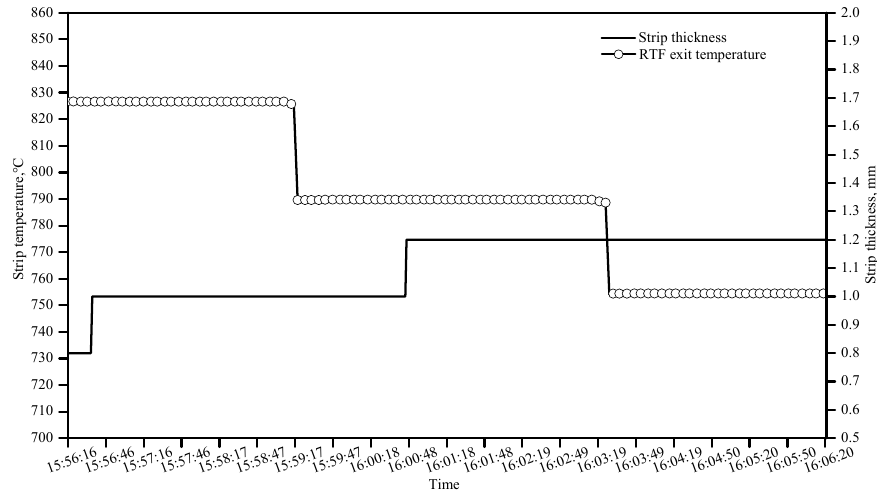
Figure 8. Response of strip temperature at RTF exit when strip thickness changes.